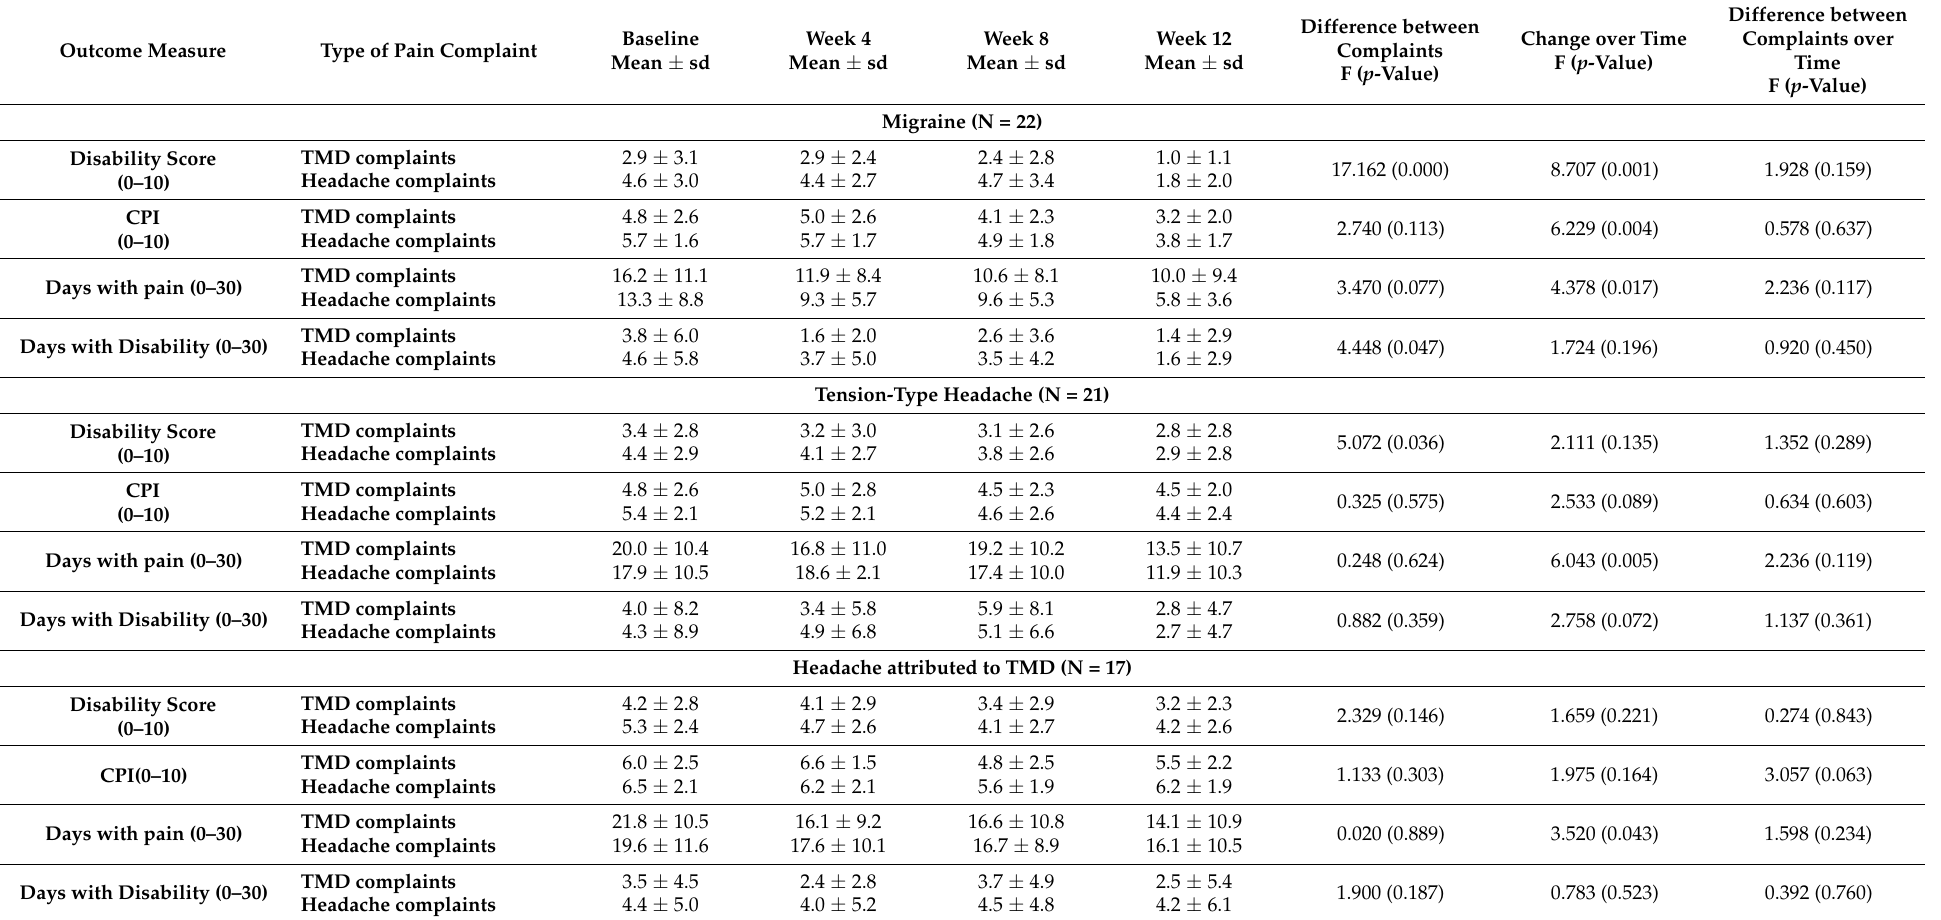
Table 2. Descriptions and general linear modeling of the Graded Chronic Pain Scale on baseline, week 4, week 8 and week 12 for the complaints related to TMD-pain and to headache.